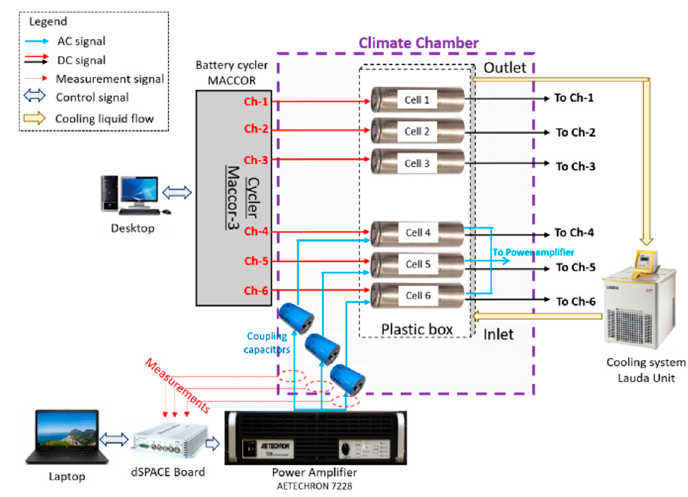
Figure 4. Experimental test rig description.